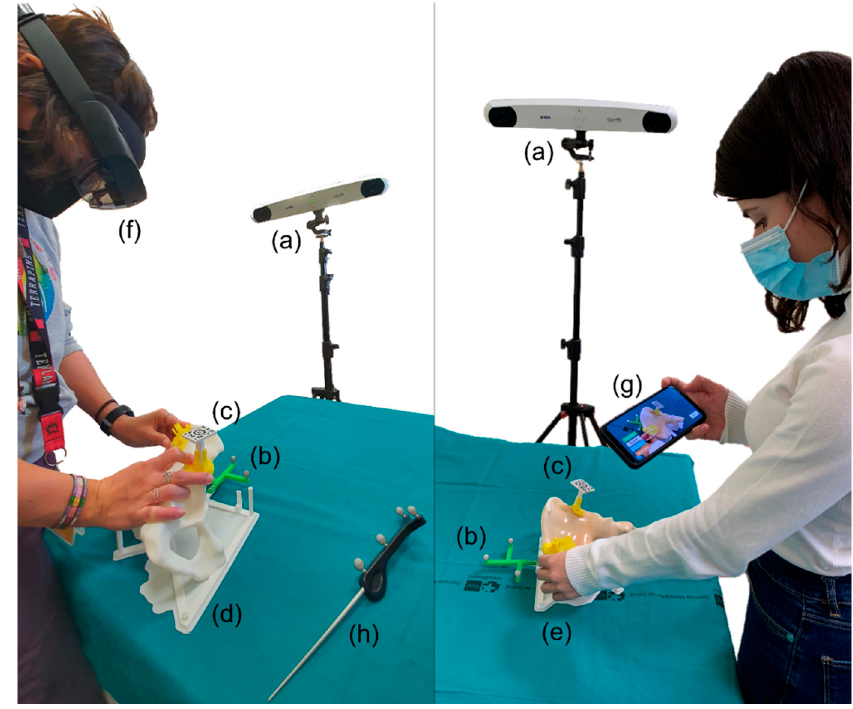
Figure 3. Setup for the assessment using ( left ) the HoloLens 2 and ( right ) the smartphone. The setups include the following elements: ( a ) optical tracker, ( b ) reference frame, ( c ) AR marker placed in PSI, ( d ) conventional, and ( e ) realistic phantom versions, ( f ) HoloLens 2, ( g ) smartphone, and ( h ) pointer.